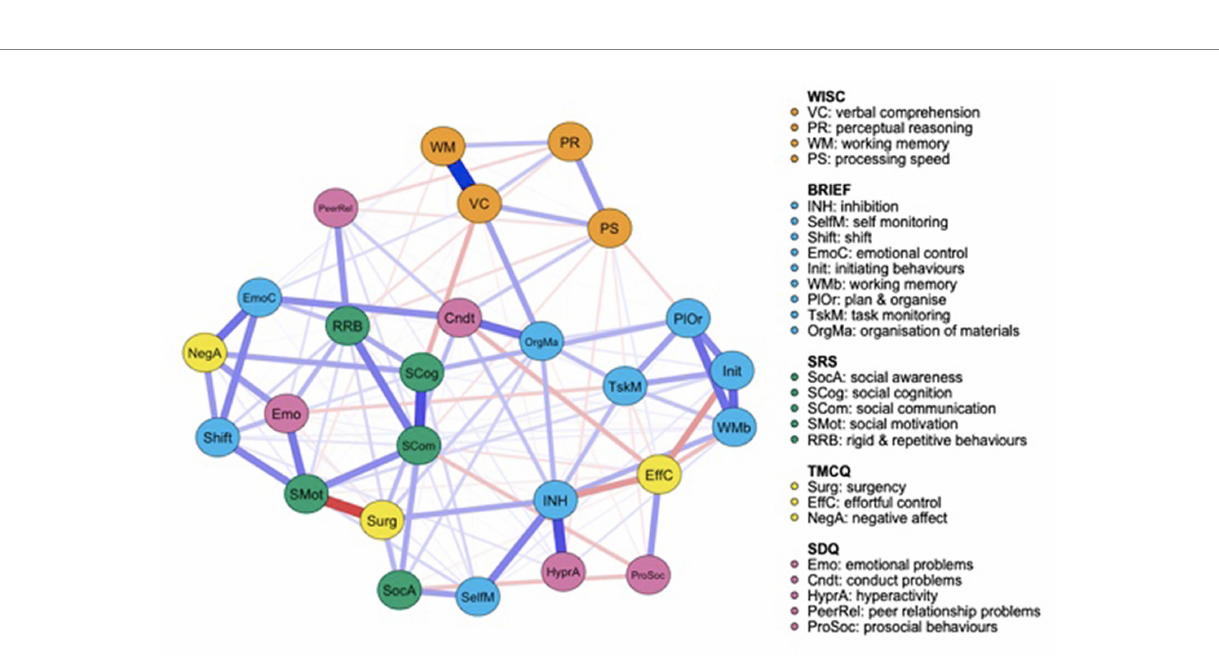
FIGURE 2 Very preterm group network structure of autism spectrum condition (ASC) symptomatology and cognitive, executive functioning, temperament and psychopathology outcome variables.